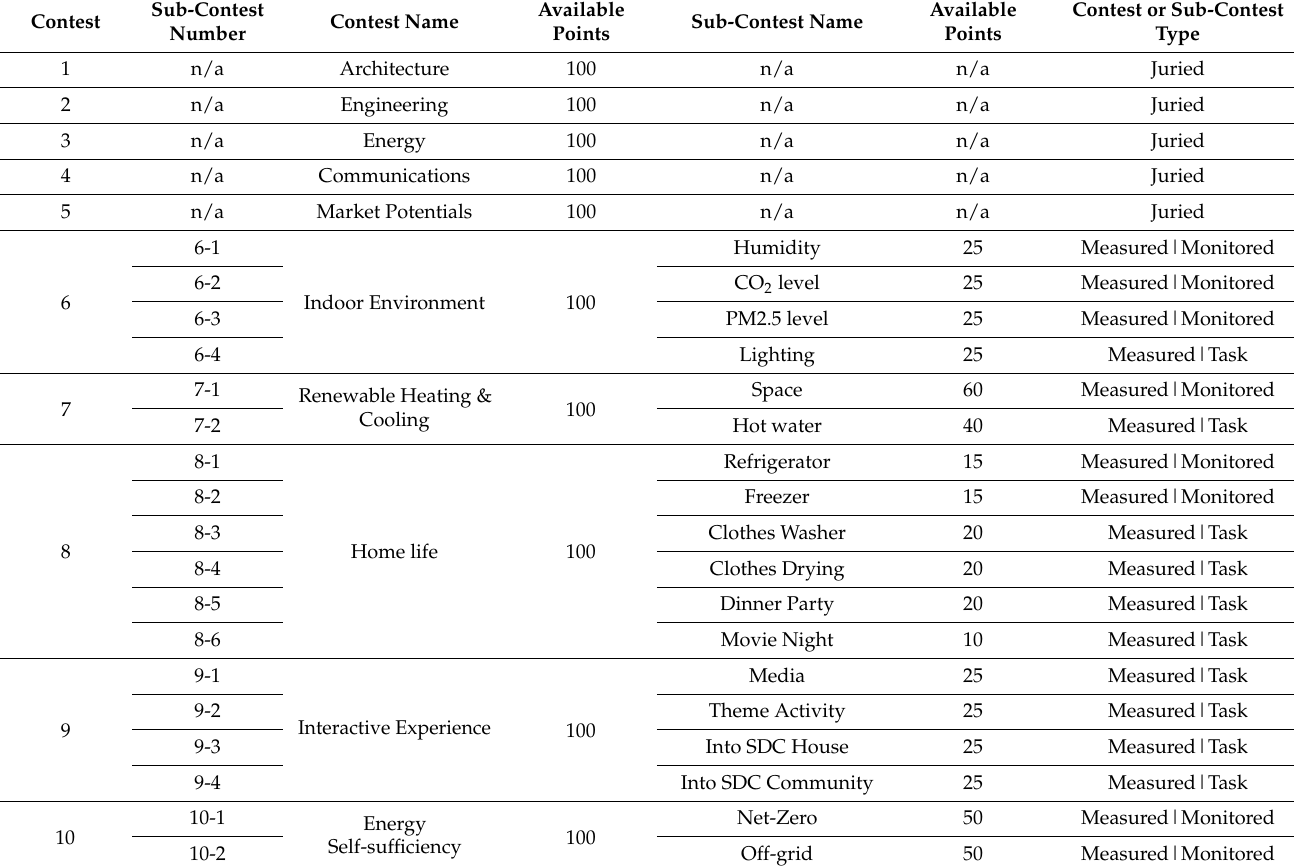
Table 2. Evaluation indices of the third SDC